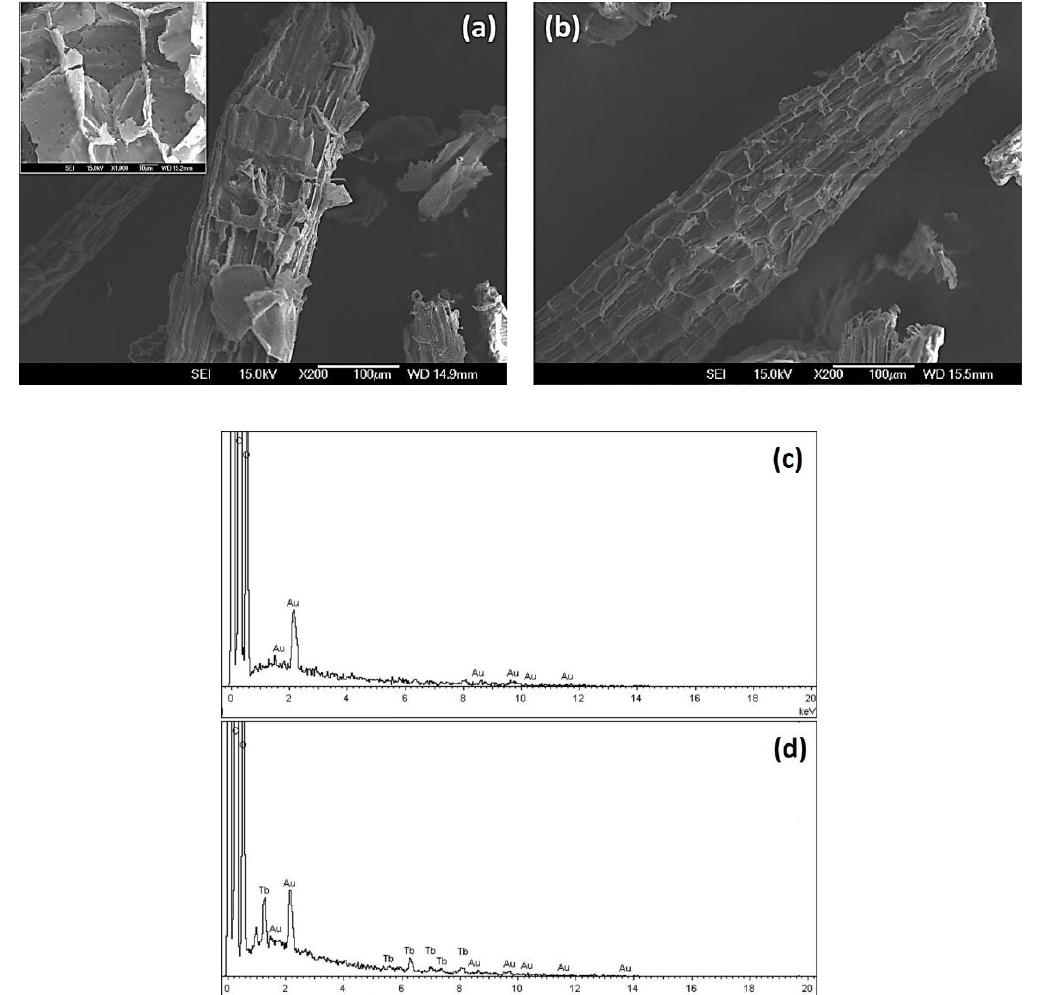
Figure 7. SEM images of the CRS bioadsorbent ( a ) before and ( b ) after terbium adsorption. ( c ) EDS spectra of the unmodified sample (CRS) and ( d ) sample after the adsorption of terbium (CRS-Tb).